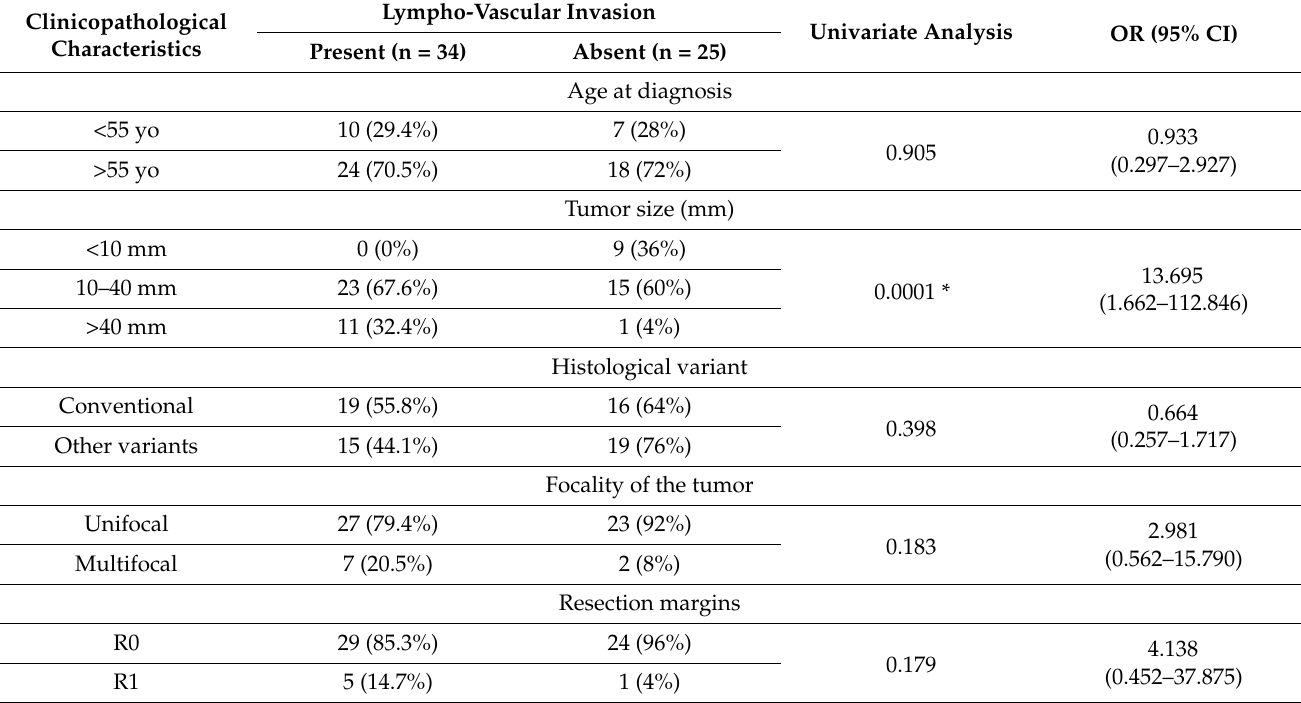
Table 5. Clinicopathological characteristics of MTC in relation to lymphovascular